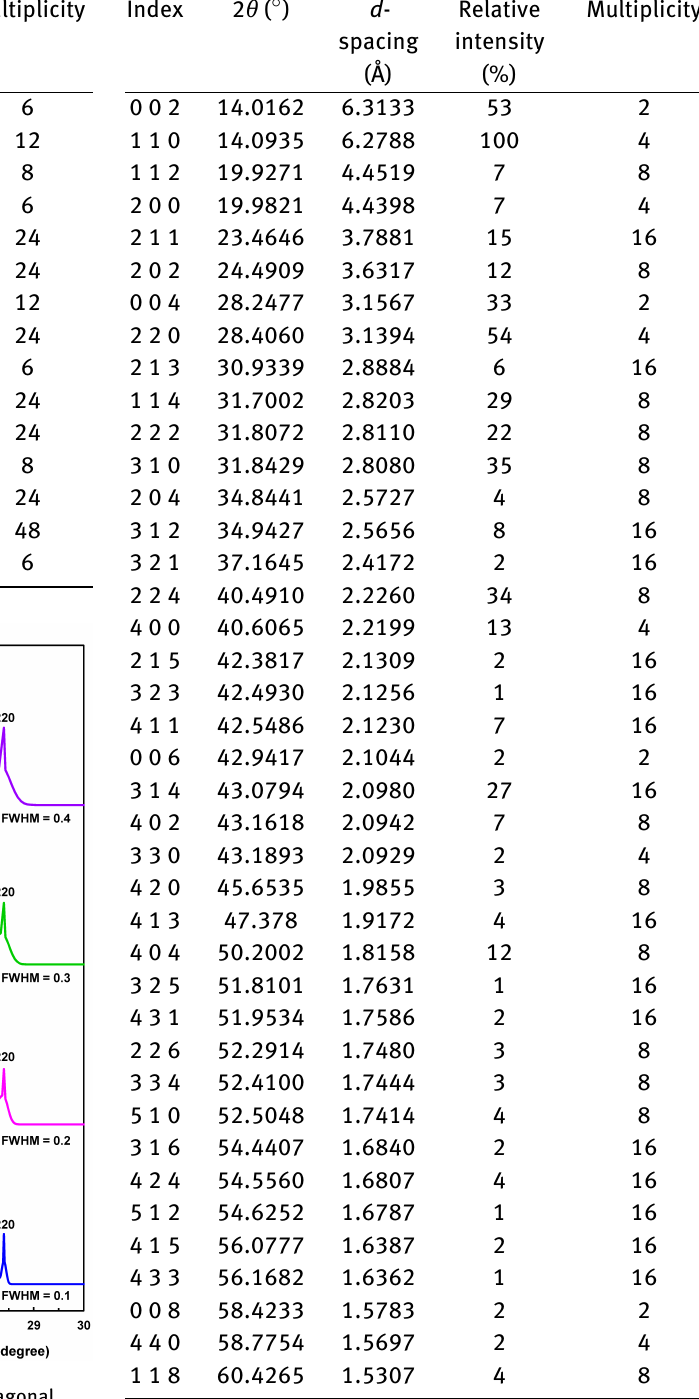
Figure 11: (a) Calculated X-ray diffraction patterns of tetragonal CH 3 NH 3 PbI 3 with various FWHM values. (b) Enlarged diffraction patterns of (a).